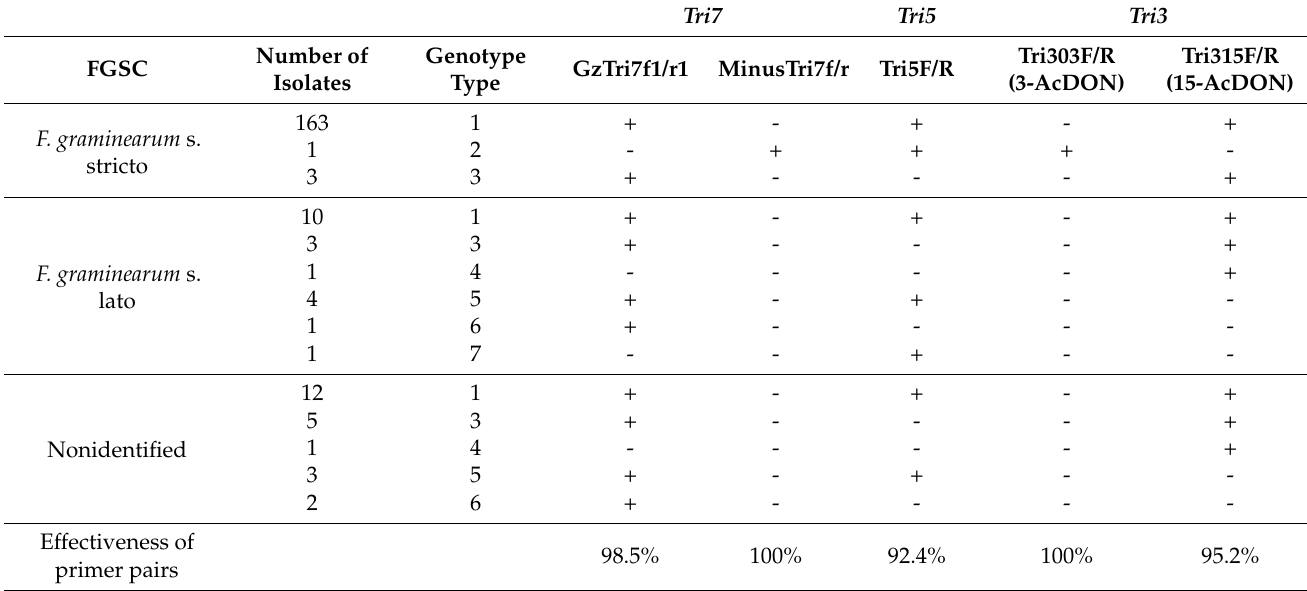
Table 3. Molecular genotypes in the F. graminearum population and the effectiveness of primer